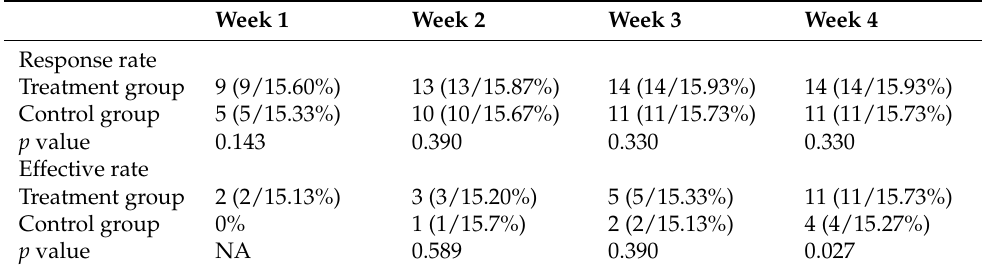
Table 4. Comparison of the effective rates and response rates between the treatment and control groups after the treatment.